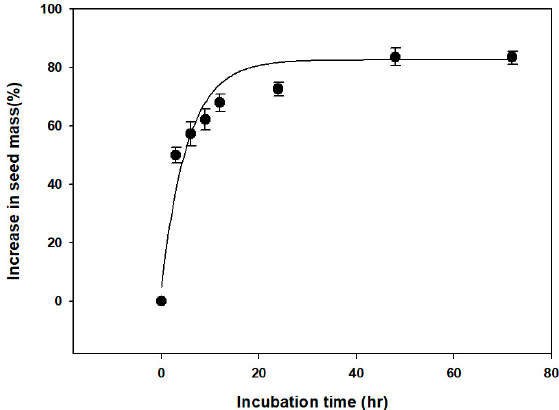
Figure 2. Water uptake by Vaccinium oldhamii Miq. seeds incubated at 20 °C on filter paper moistened with distilled water for 0–72 h. Error bars indicate mean ± standard error (n = 4).